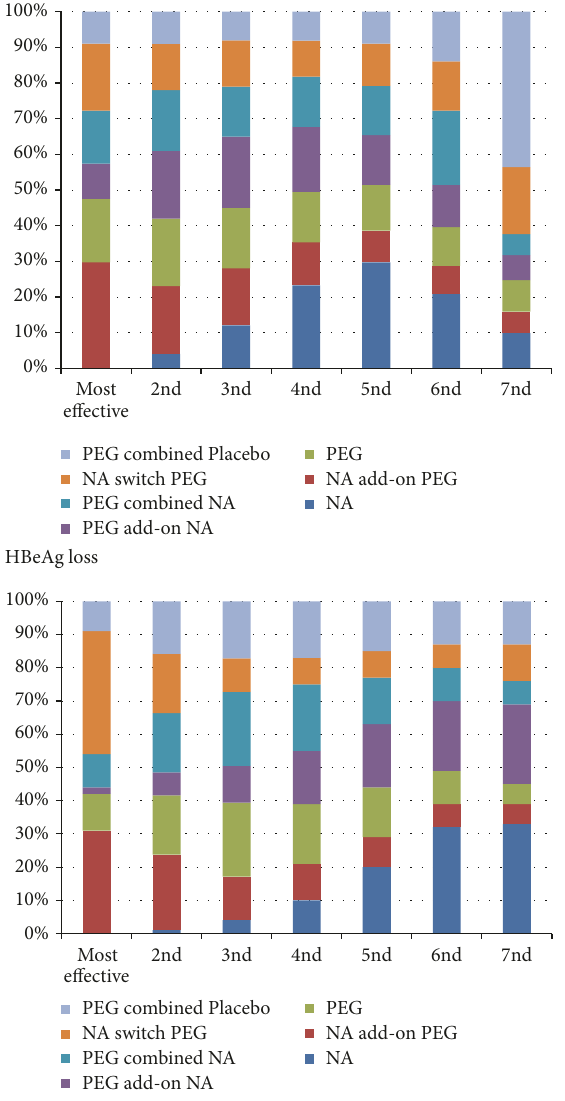
Figure 3: Rankogram reporting the probabilities of being the best treatment (reflective of the length in stacked bar for each drug in given column) in terms of HBeAg loss and HBeAg